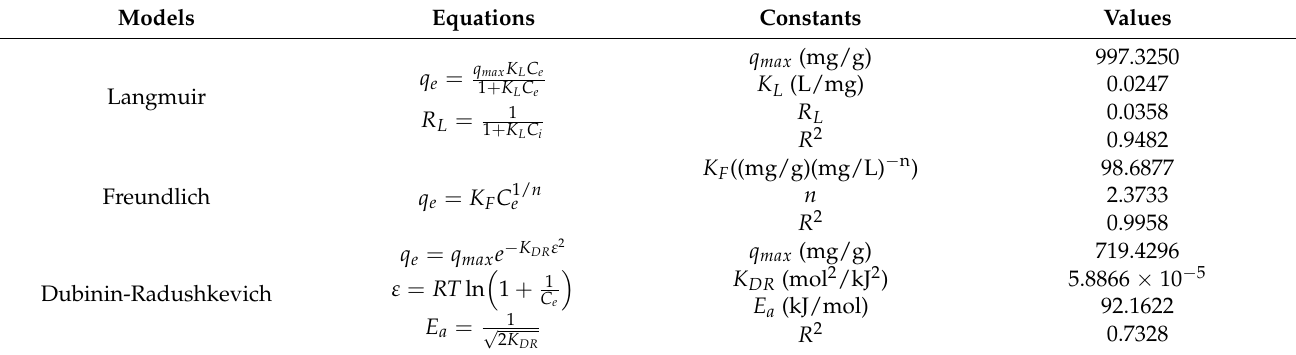
Table 6. Adsorption isotherm modelling constants of CV dye adsorption onto